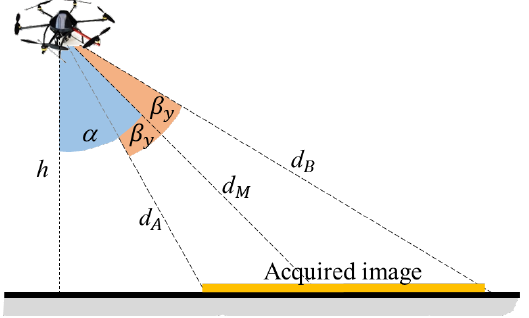
Figure 5. Geometry of an oblique image acquired from a UAV.